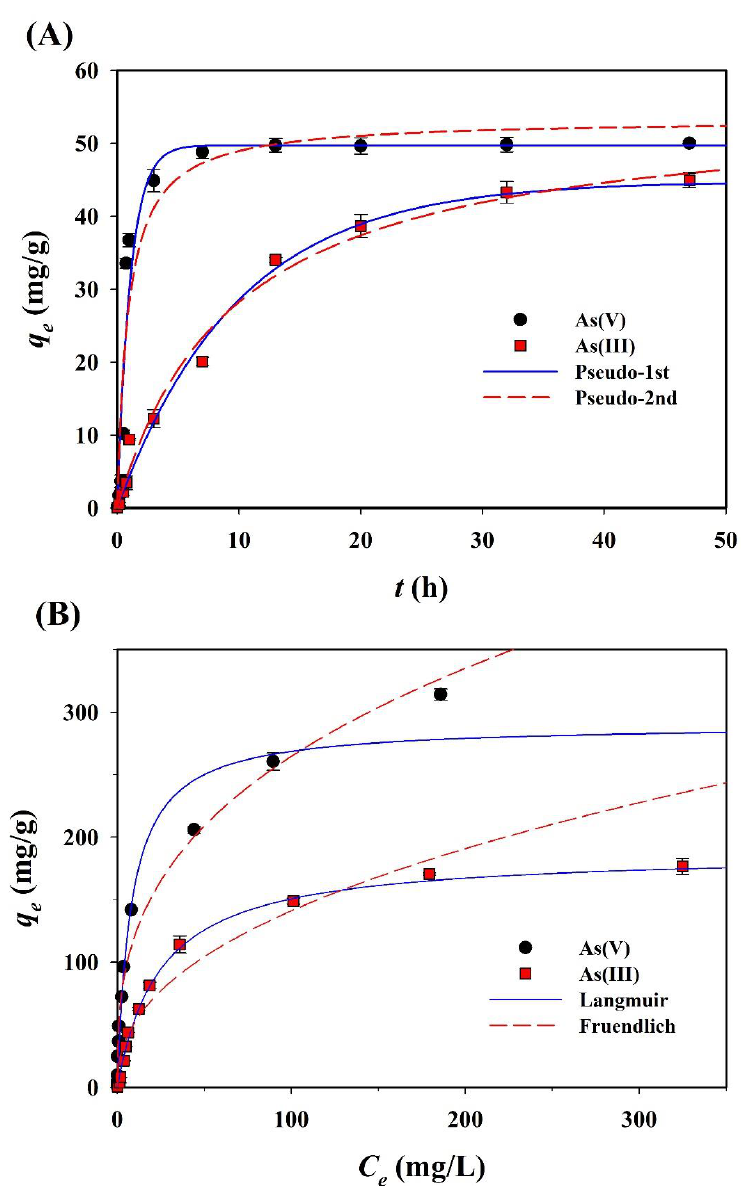
Figure 7. Experimental and plotted data of ( A ) sorption kinetics and ( B ) isotherms for As(III) and As(V) sorption on the CF-NCs.